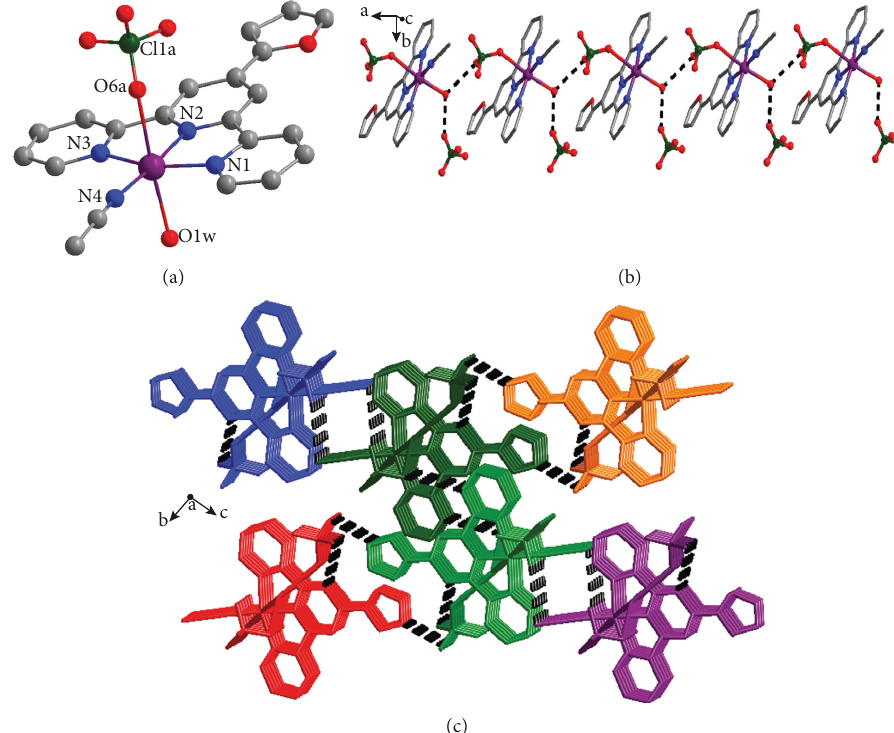
Figure 1: (a) The coordination surroundings of Cu(II) ion in compound 1 . (b) The 1D chain structure constructed through the linkage of O1W-H ... O H bonds. (c) The 1 ’s 3-dimensional supramolecular structure via the linkage of the C-H ... O H bonds (dotted lines: H bonds).